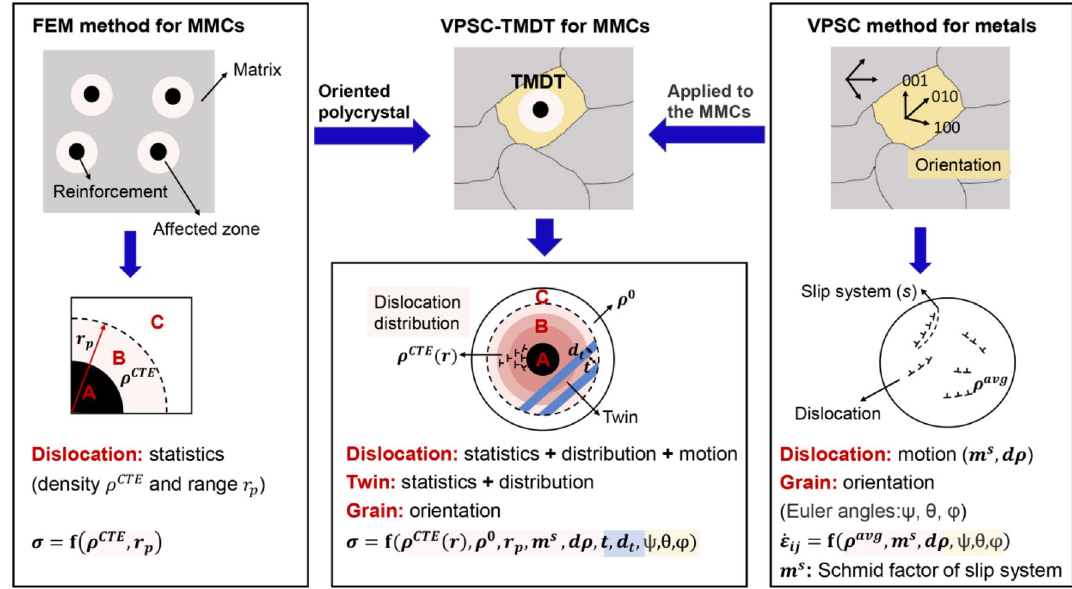
Figure 5. Schematics showing the differences of influential factors in VPSC-TMDT model, FEM, and VPSC methods. About the element in the TMDT model, it combines the spatial structure in that of FEM method and the physical mechanism of VPSC method, with emphasizing on the heterogeneous dislocation distribution and nanoscale twins in the thermal mismatch affected